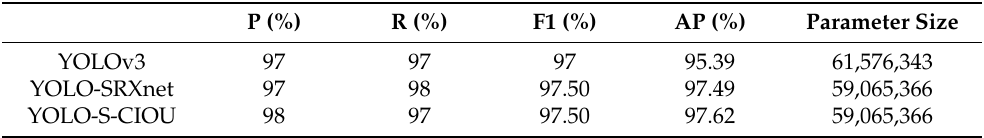
Table 2. Specific index values of three